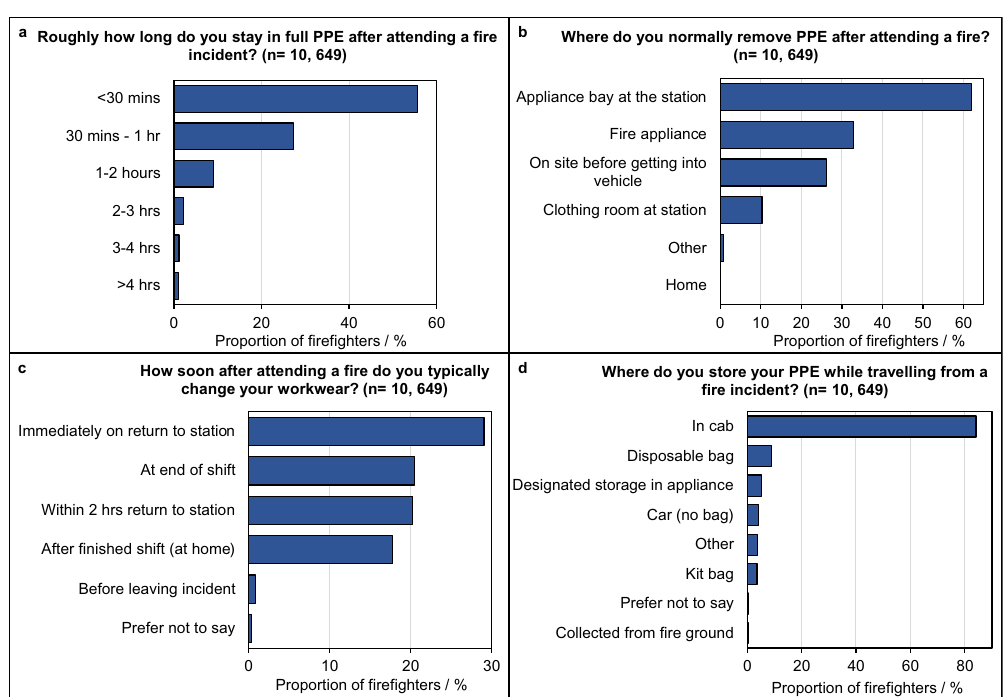
Figure 3. PPE de-robing and storage after fire incidents. Proportion of total surveyed firefighters indicating: ( A ) how long they would normally remain in PPE after attending a fire, ( B ) where they would normally de-robe PPE after a fire, ( C ) how long they would normally remain in workwear after a fire, and ( D ) where PPE is normally stored while travelling back from a fire incident. Note, firefighters were able to select multiple answers to the questions presented in this